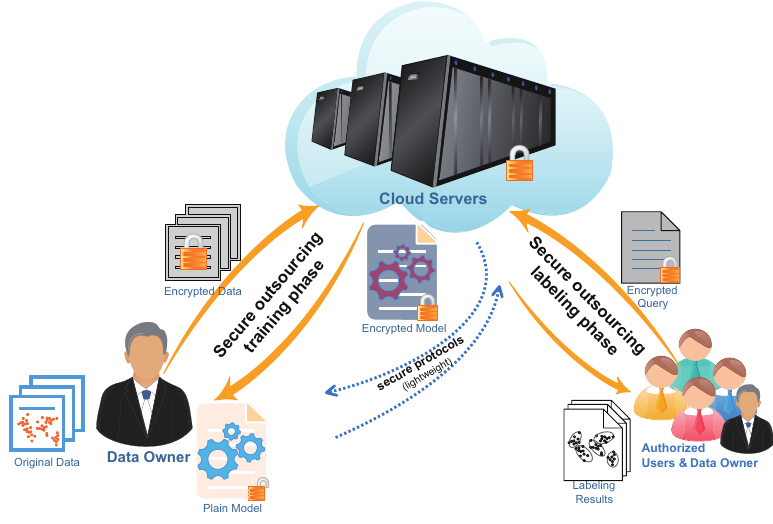
Figure 1. Architecture of secure outsourcing each phase of